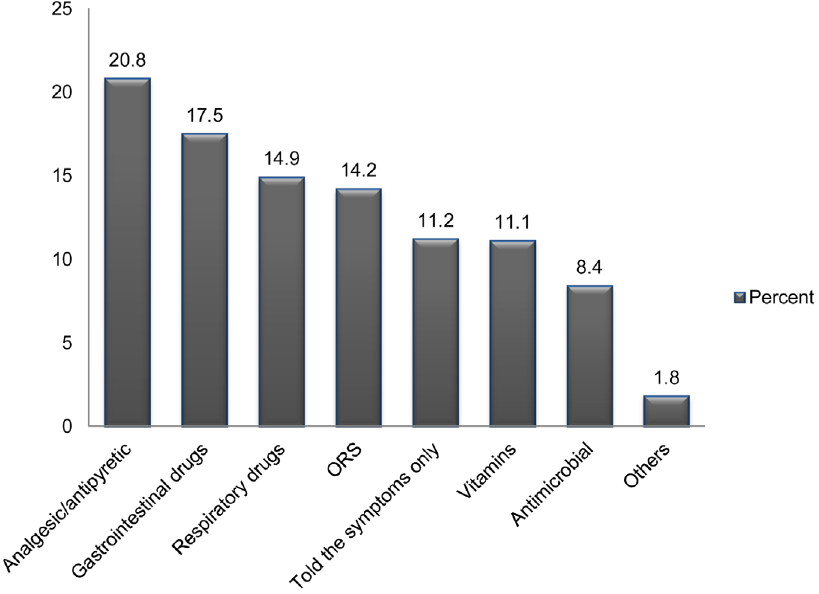
Figure 2. Category of drugs requested for self-medication (n=270). Figure 2 demonstrates the most frequently requested category of drugs by self-medicated respondents. The most commonly requested category of drugs were analgesics/antipyretics (20.8%), GI drugs (17.5%), respiratory drugs (14.9%), ORS (14.2%), vitamins (11.1%) and antimicrobials (8.4%).